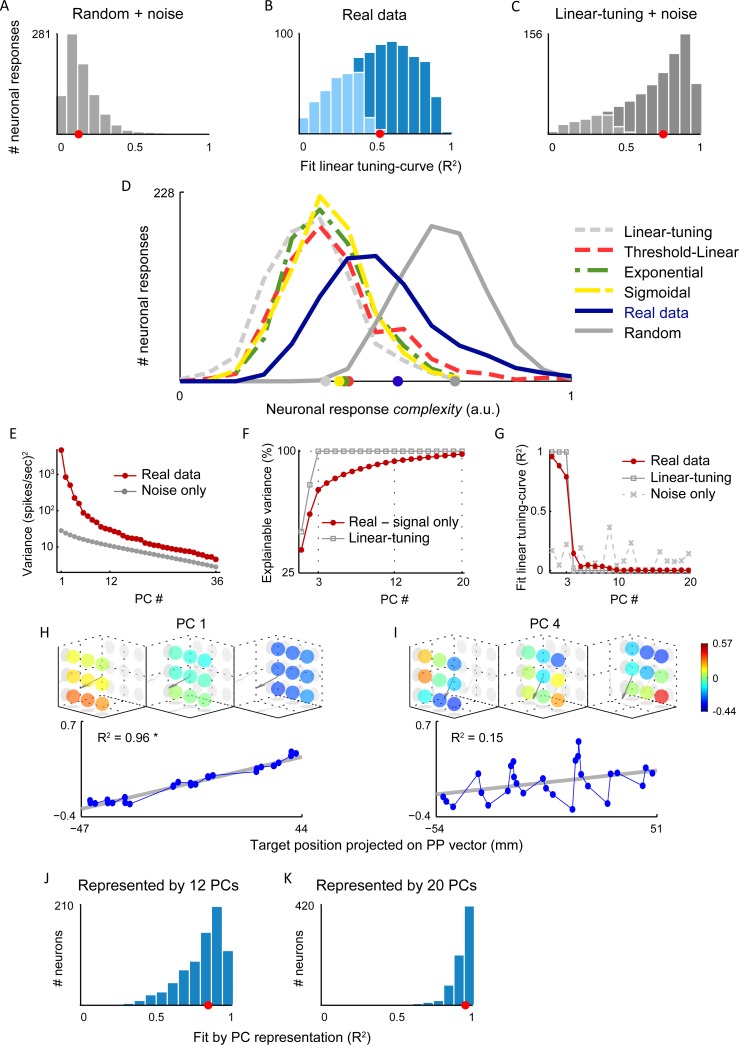
A. Distribution of R2 values for fit of linear tuning-curve to uniformly random artificial responses (median = 0.15), with addition of noise traces from real data (repeated 1,000 times). Almost all fits were not significant (F-Test, p < 0.01), denoted by light gray bars. B. Same as A but for real data, including the responses for all tuned neurons (N = 411) for both forearm rotation angles, significant fits (F-Test, p < 0.01) are denoted by dark blue (median = 0.52). C. Same for the artificial spatial linear control dataset. Distribution (median = 0.76) significantly different from that for real data (Wilcoxon rank-sum test, p < 10−27). D. Distribution of complexity measure across (normalized) response functions. Blue for the real neuronal responses, other colors for matched spatial linear, smooth nonlinear, and uniformly random control datasets, all with added real noise traces. Means (plotted on x-axis) significantly different for controls than for real data (t-test, p < 10−40 for the closest distribution). E. PC variances of the response functions across 54 conditions, and PC variances of noise traces sampled from the data (resampled 1,000). Variance explained by first 12 PCs of data is above variance of first noise PC, and variance of first 36 PCs of data is above the mean noise variance. The 99% confidence interval of the mean of the variance of the noise traces is indicated by the thickness of the gray line, and is smaller than the round markers. F. PCA of response function of both forearm angles (27 conditions each). Percent cumulative explainable variance as function of PC number, computed by subtracting the noise variance from total variance of the real data. In gray, the variance of purely spatial linear control (without noise). G. R2 values for fit of PCs to linear tuning-curve, for real data (red), purely spatial linear (gray and squares), or real noise traces (dashed gray and x’s). For real data and linear control only first 3 PCs have a significant fit to linear tuning-curve. Mean R2 for fit of each of noise PCs, across the 1,000 resamples is plotted, showing chance level for fitting noise to linear tuning-curve. H. 1st PC vector of real data plotted in the same format as the neuronal responses (Fig 2A and 2C); here color denotes the PC coefficient. This PC vector is the most spatially linear and represents one dimension of the spatial linear component. I. Same for 4th PC vector. This PC vector is highly nonlinear and is part of basis representing the nonlinear structure of responses. (See the first 20 PC vectors in S3 Fig). J. R2 distribution for the “model” formed by representing each response function by the first 12 PC vectors (median = 0.84). K. Same as H when using the first 20 PC vectors (median = 0.95).